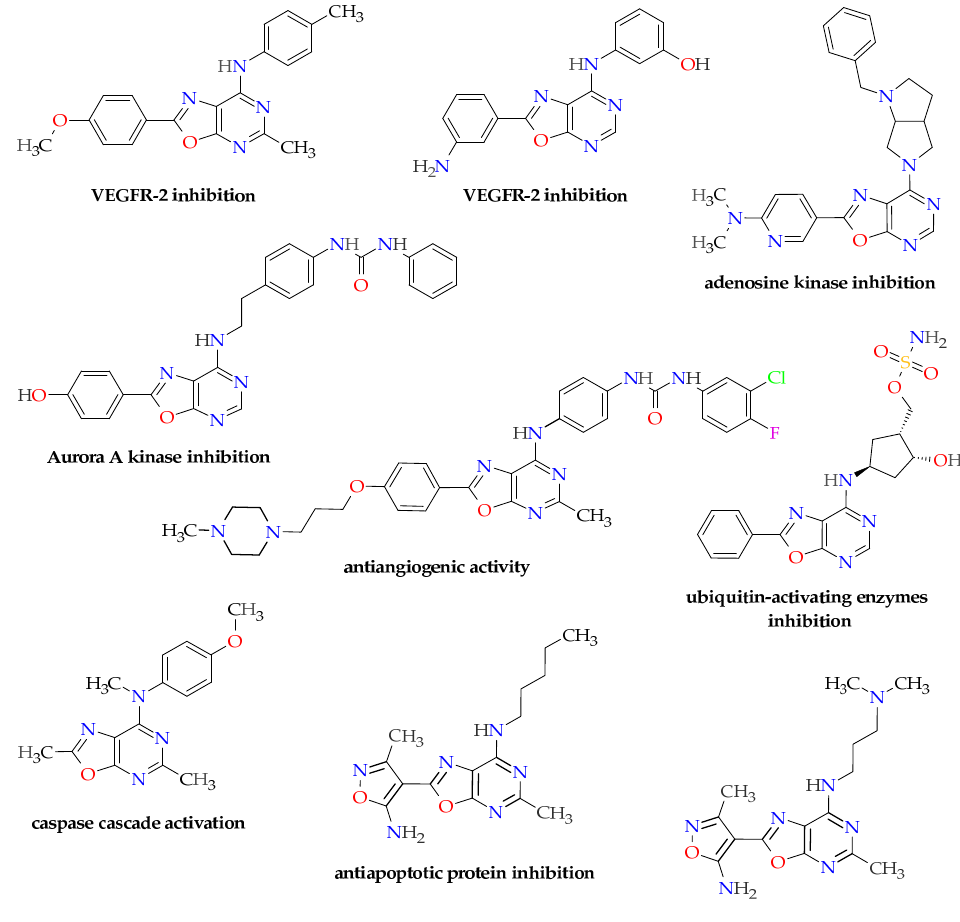
Figure 2. Oxazolo[5,4- d ]pyrimidines reported as anticancer agents with identified molecular mechanisms of action.